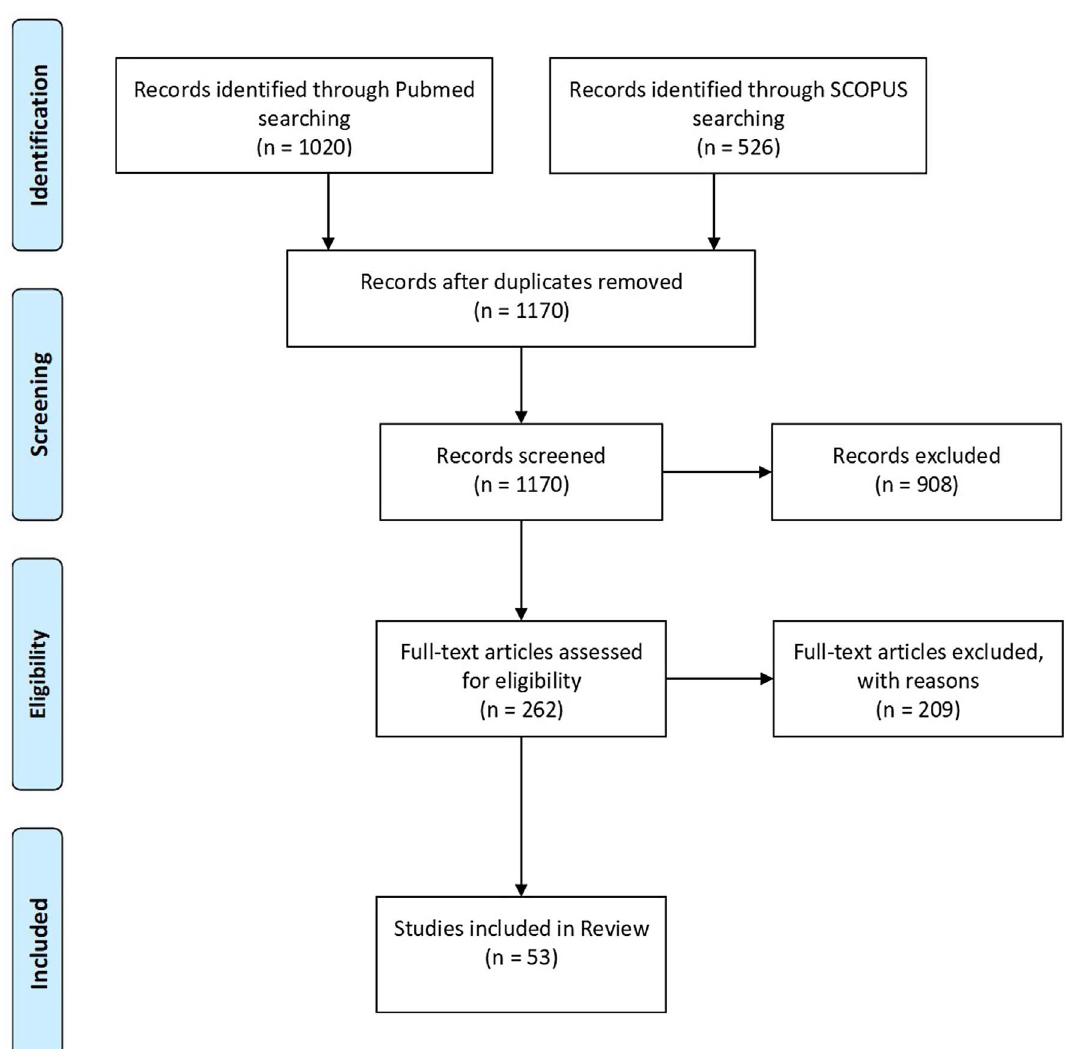
Figure 1. The PRISMA fl ow chart employed showing the article selection process for the